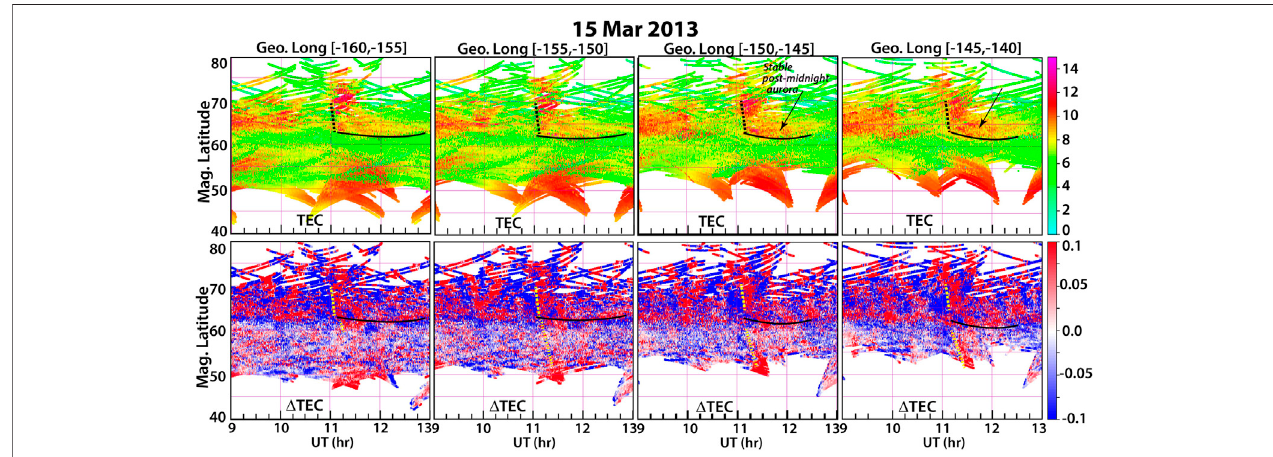
FIGURE 10 | Average TEC and Δ TEC over 5 ° geographic longitude increments from west of, to 5 ° east of, Poker Flat on March 15, 2017, in the same format as Figure 4 .